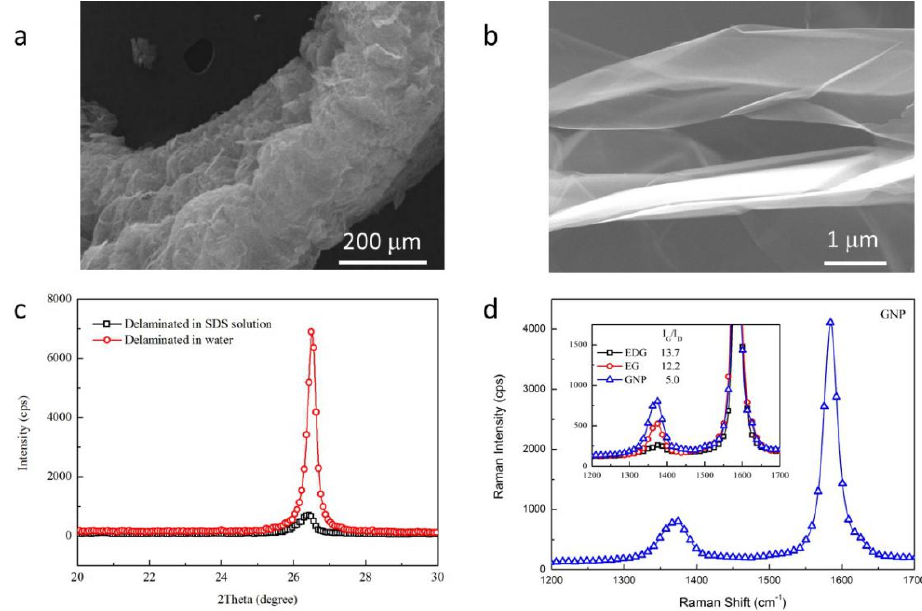
Figure 1. ( a , b ) SEM micrographs of EG, ( c ) XRD patterns of delaminated products of EG in water and SDS solution, ( d ) Raman spectrum of GNPs with inserted spectra of EDG, EG and GNPs.